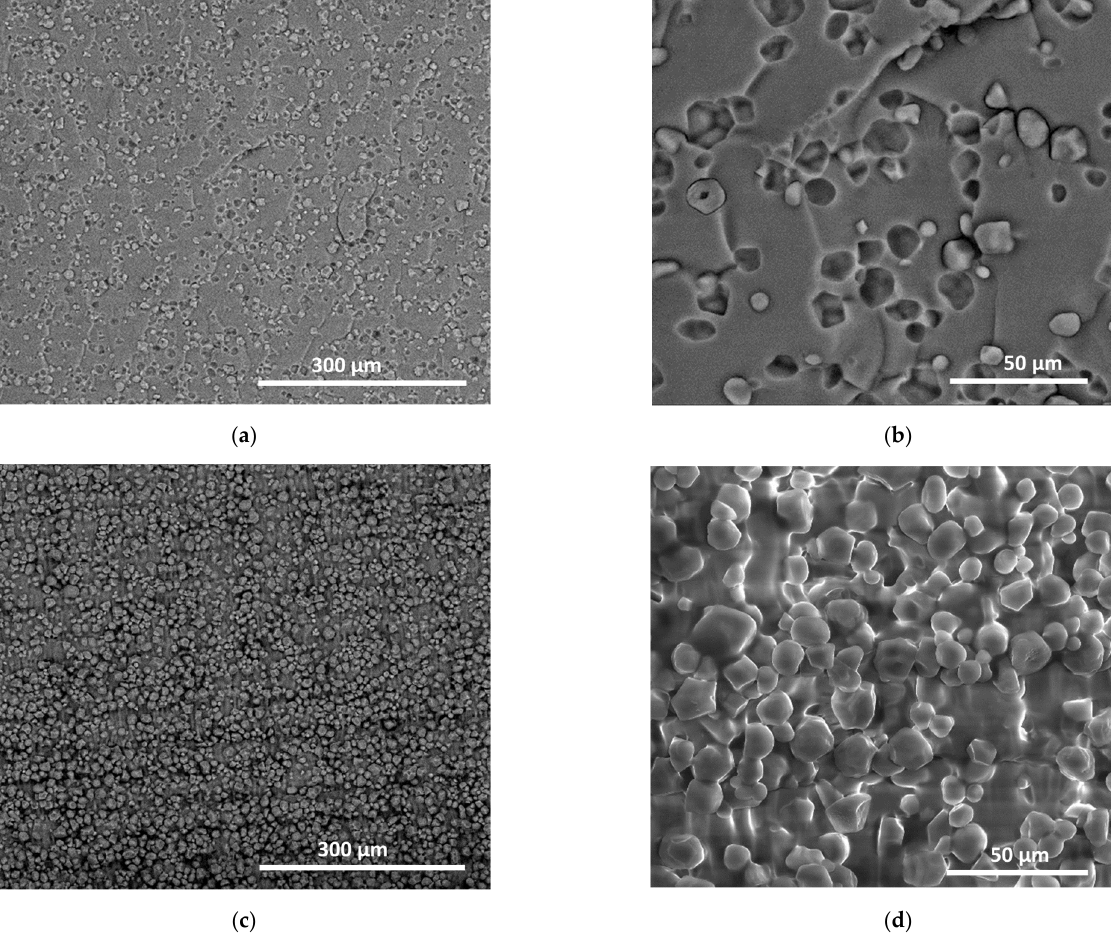
Figure 11. SEM micrographs of 3D-printed composites reinforced by starch granules. ( a , b ) surface view, and ( c , d ) bulk view.